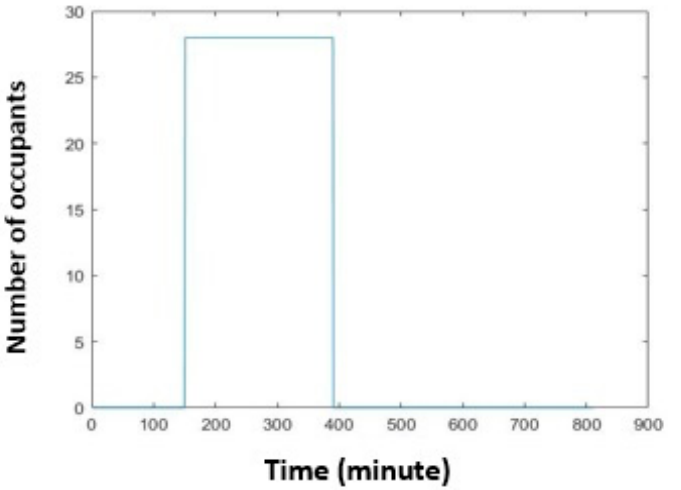
Figure 11. Occupancy versus time in 12 h of experimentation in a theoretical classroom with a medium size.